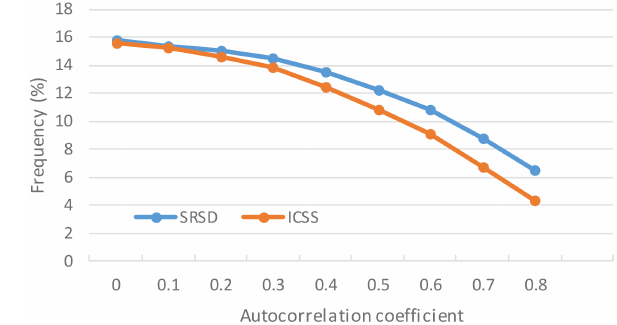
Figure 7. Percentage of hits as a function of the autocorrelation coefficient in experiments with one change point at c 1 = 51 between = (1 , 3). The parameters for SRSD were two variance regimes σ 2 j set as p = 0 . 1, l = 40, and h = 2.